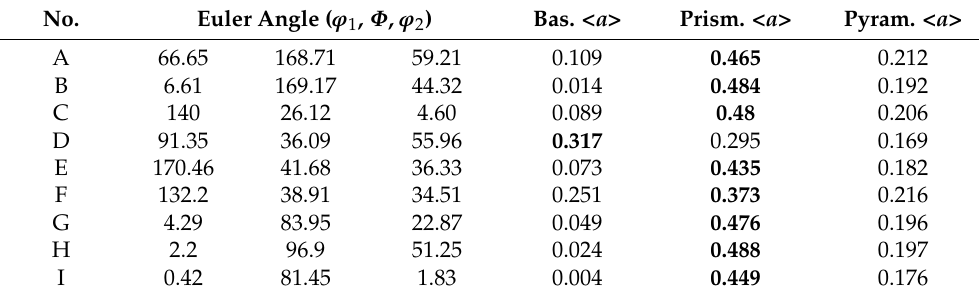
Table 2. Calculated SF N values for slip modes of selected grains in the RD sample. No. Euler Angle ( ϕ 1 , Φ , ϕ 2